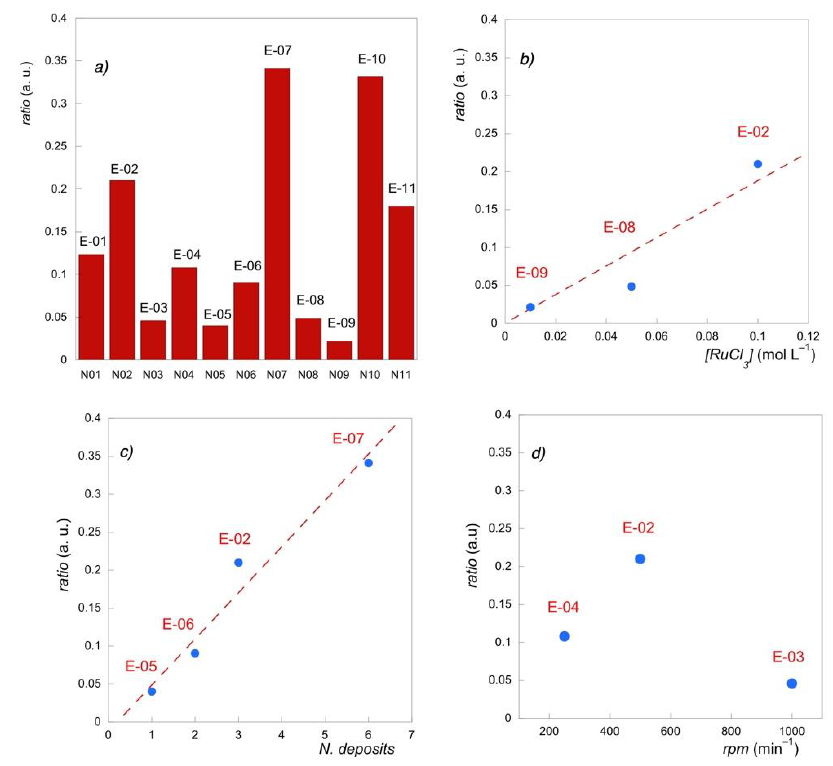
Figure 2. Atomic ratio of Ruthenium to the total metal content from EDX values ( a ) for all the electrodes; ( b ) vs. precursor concentration; ( c ) vs. number of deposits; ( d ) vs. spin rate.